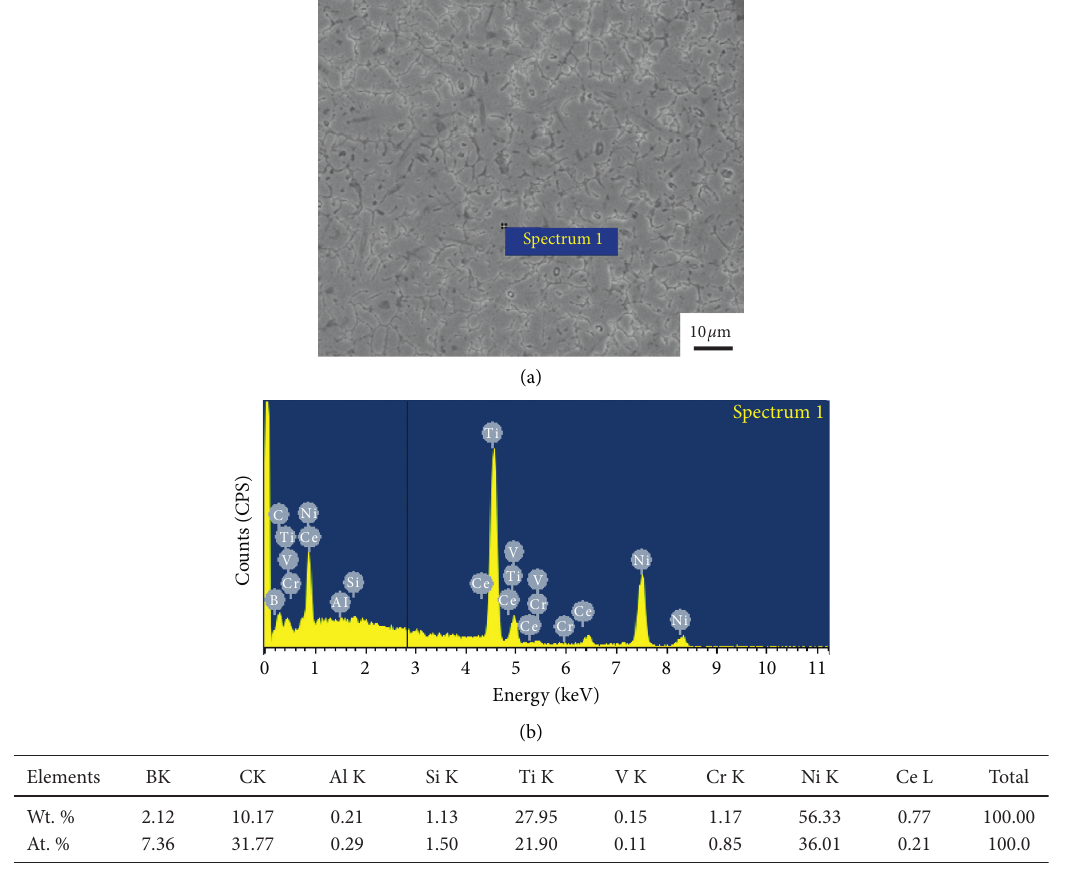
Figure 4: The point spectrum analysis of the cross section of sample S2: (a) the cross section of the S2 coating, (b) elements distribution of coating, and (c) the atomic ratio of